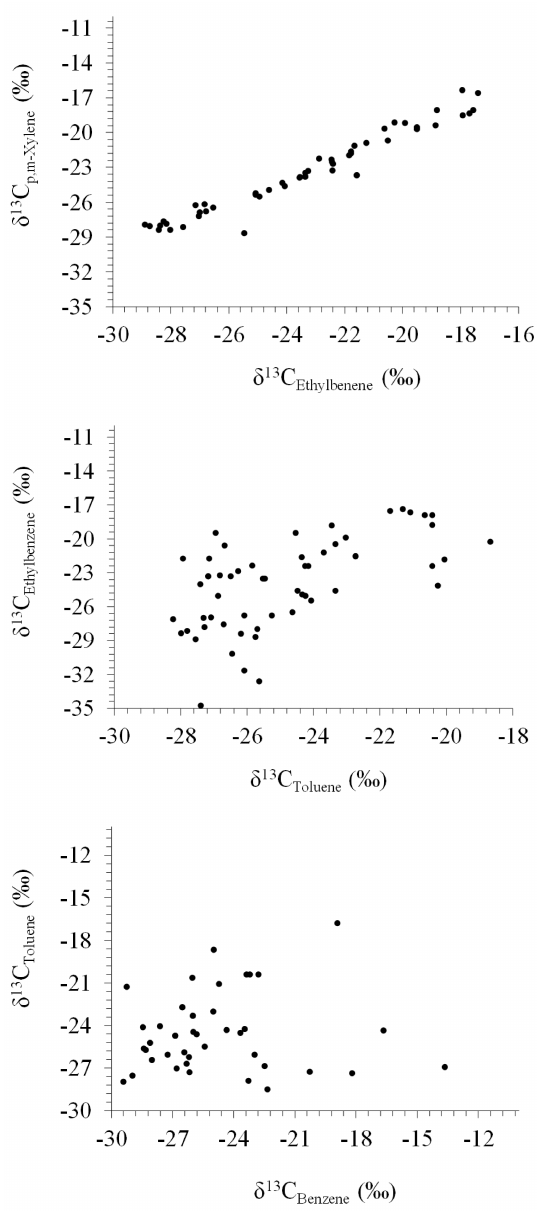
Figure 4. Example plots for the dependence between carbon isotope ratios for different VOC pairs.